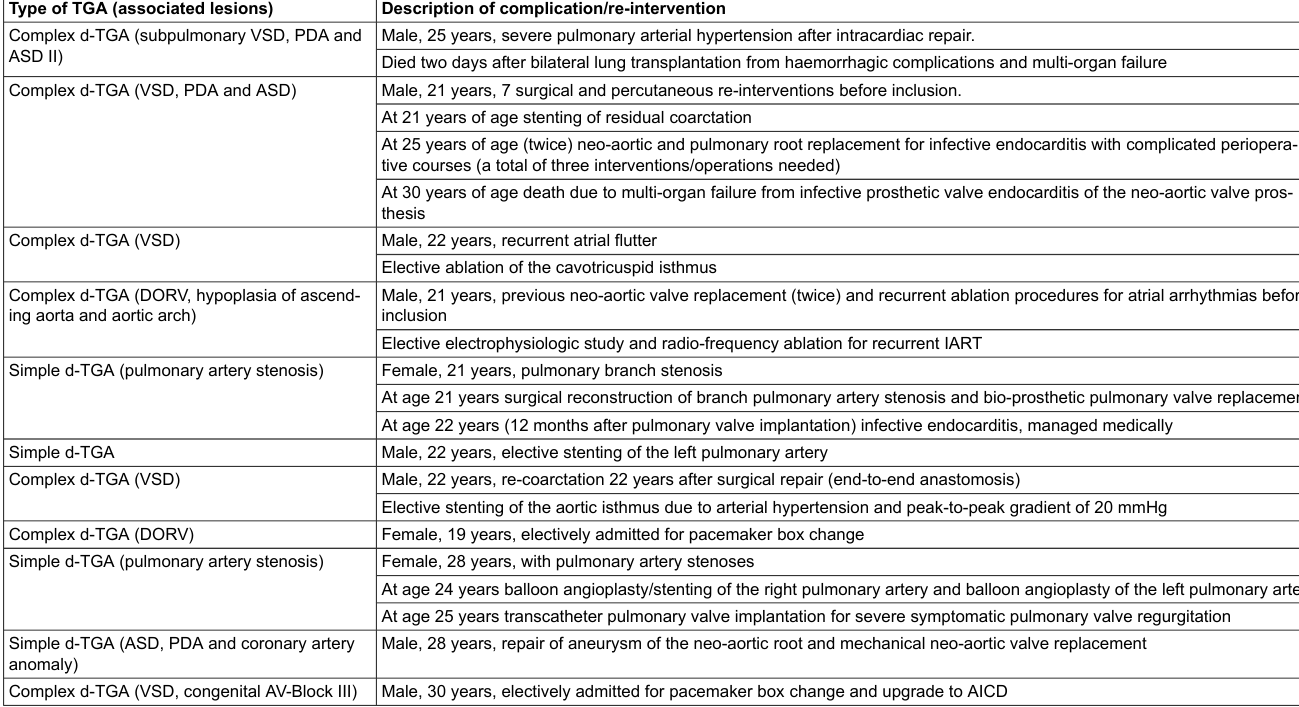
Table 3: Cardiovascular-related events during follow-up. Type of TGA (associated lesions) Description of complication/re-intervention